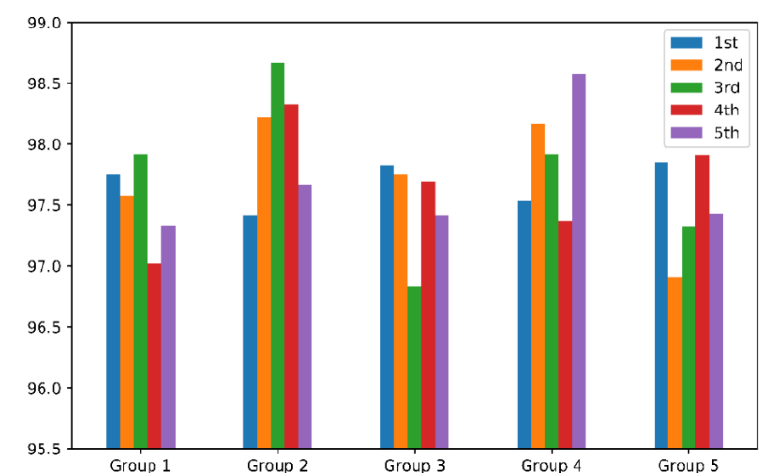
Figure 14. The diagram of cross-validation.